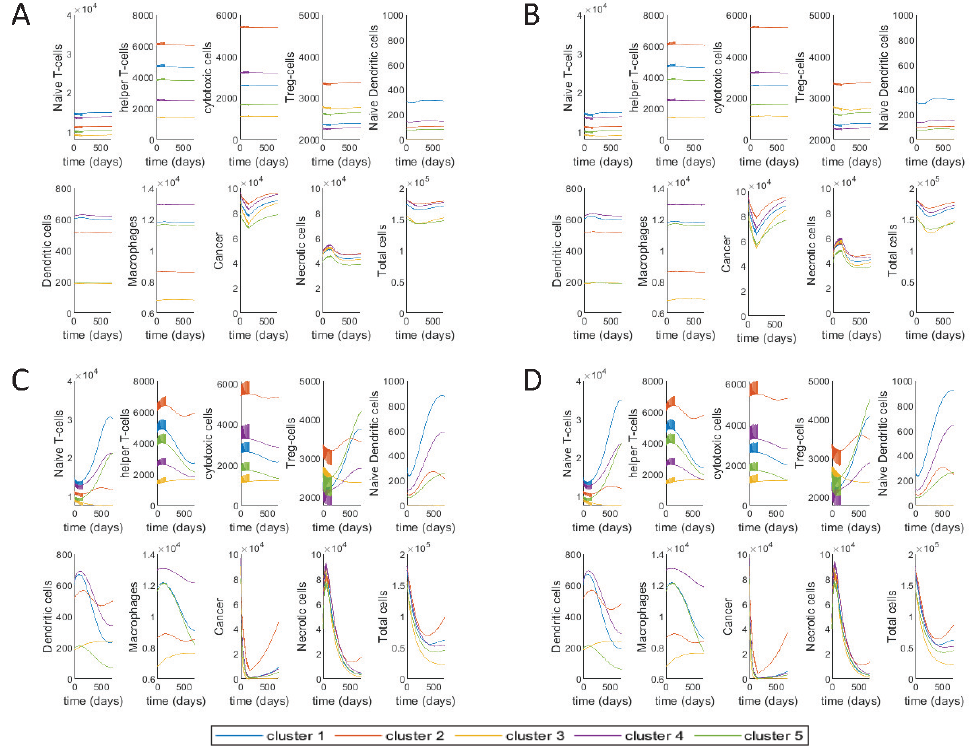
Figure 4. Varying combinations of the FOLFIRI drugs. In ( A ), we use the median dosage for 5-FU as the initial infusion dose, keeping the values of Leucovorin and Irinotecan zero. In ( B ), we add the median dose of Leucovorin to that of 5-FU, keeping Irinotecan dose at zero. Similarly in ( C ), 5-FU and Irinotecan are infused at the median dosage, while keeping Leucovorin at zero. ( D ) is the model results obtained from infusing all three drugs at median dosages. Median dosages are given in Table